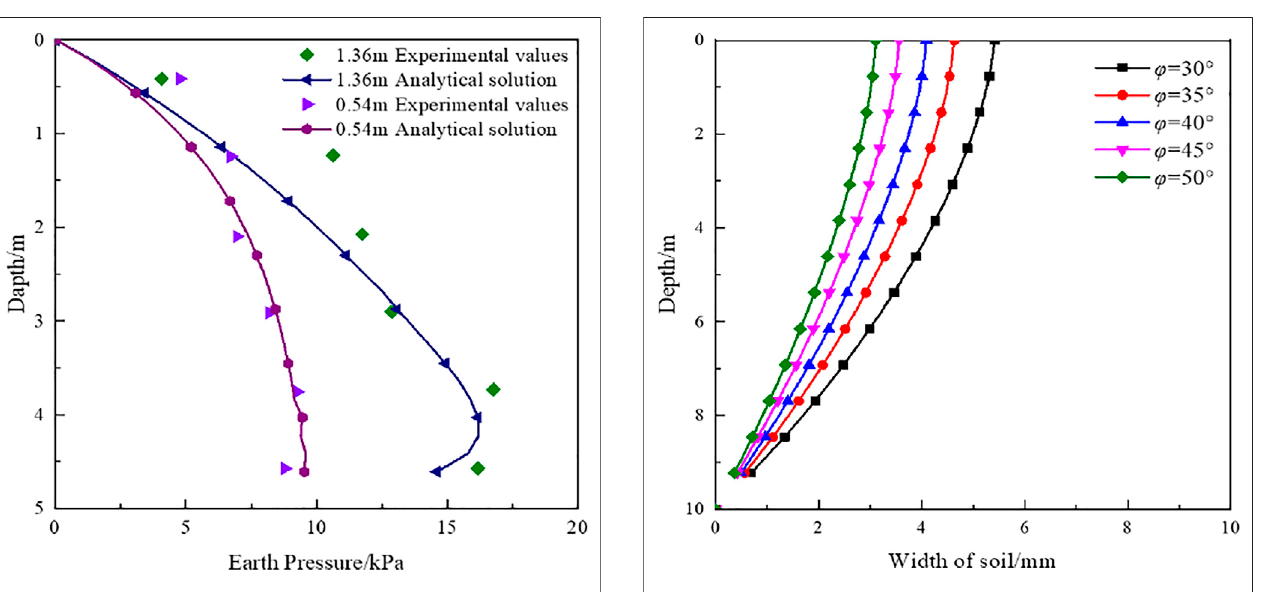
FIGURE 9 | Comparison of lateral earth pressure. FIGURE 10 | In fl uence of the internal friction angle on the slip